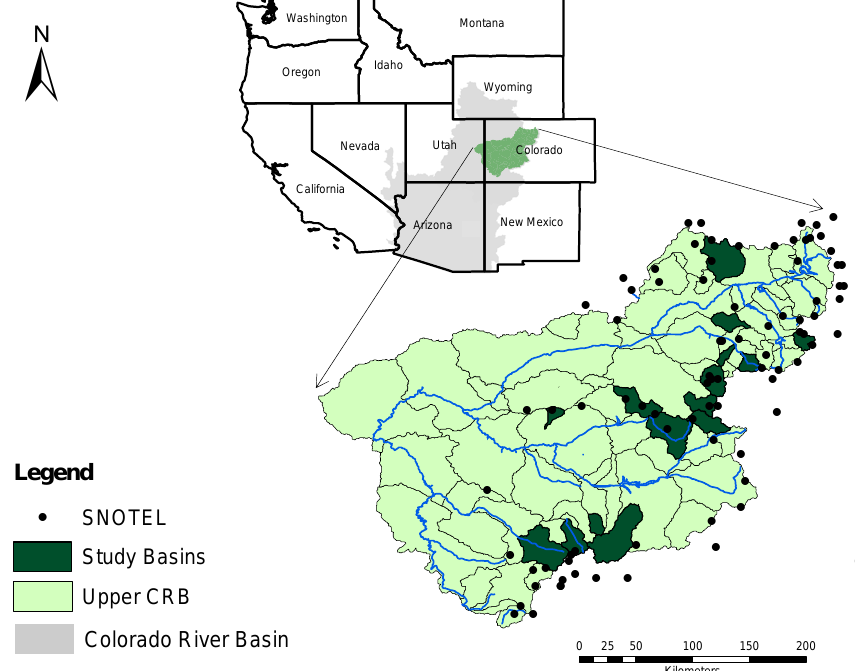
Figure 1. Map of the Upper Colorado River Basin (CRB) with highlighted study basins and SNOTEL locations. Table 1. Basin data for all of the study